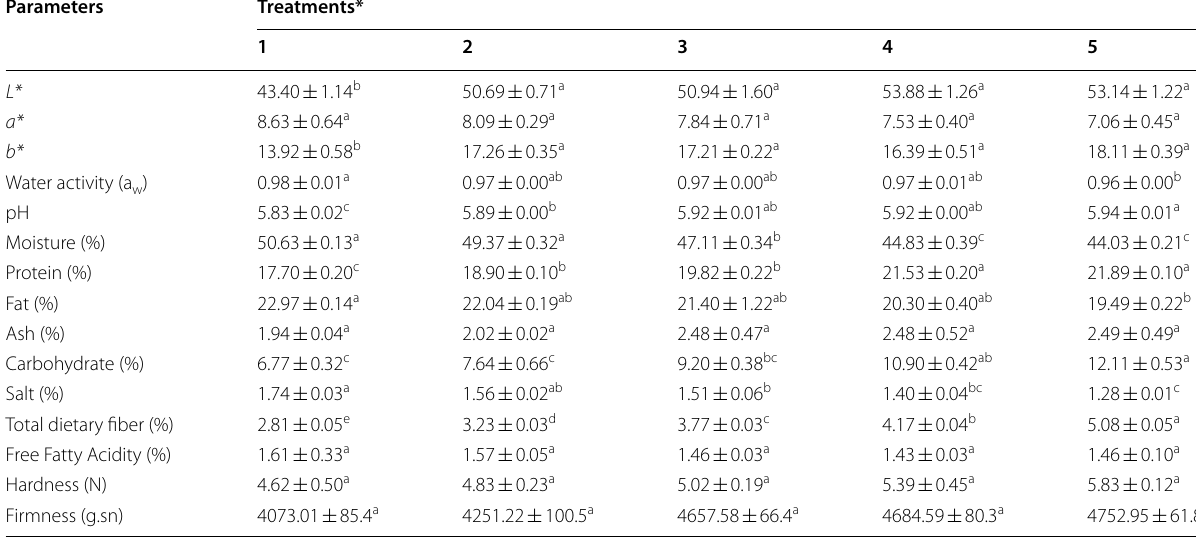
Values are means standard error of three replicates ± *(1): Raw control sample, (2): 2% cowpea flour was added raw sample, (3): 4% cowpea flour was added raw sample, (4): 6% cowpea flour was added raw sample, (5): 8% cowpea flour was added raw sample. Means within the same row with diffeerent superscripts are significantly different ( P < 0.05)